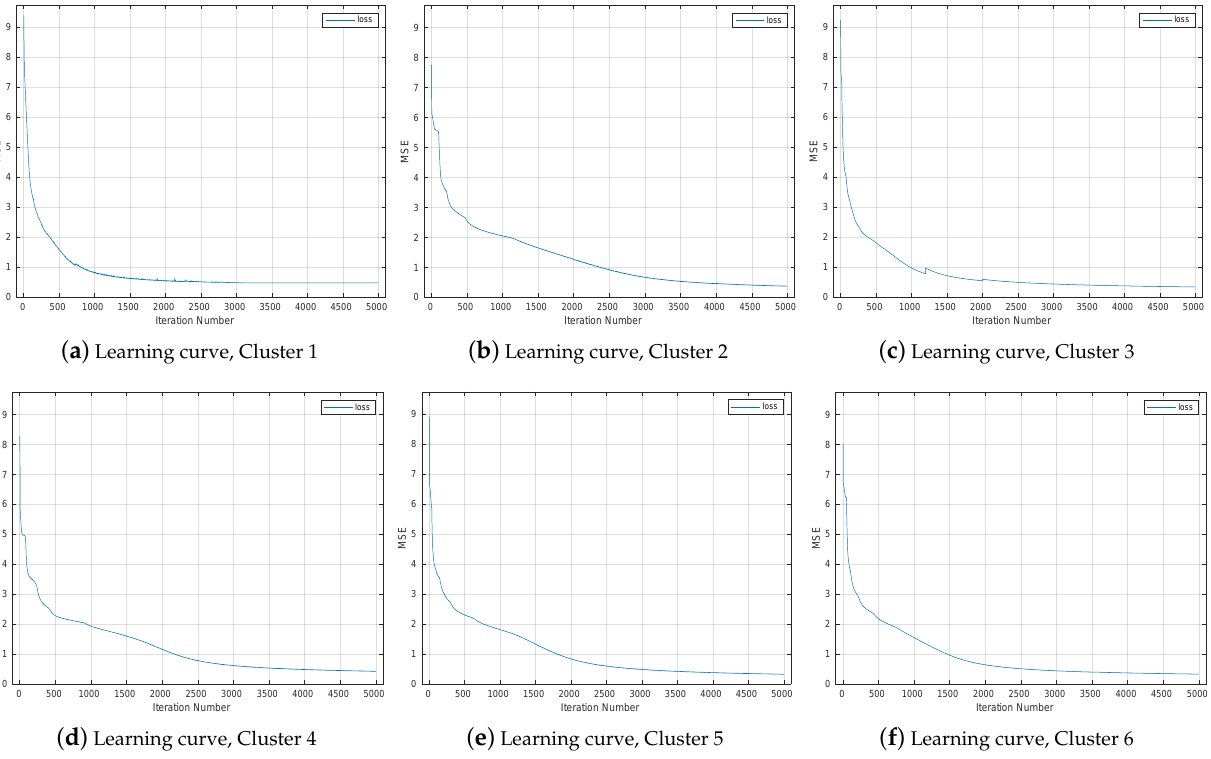
Figure 16. Mean squared error (learning curve) using cluster